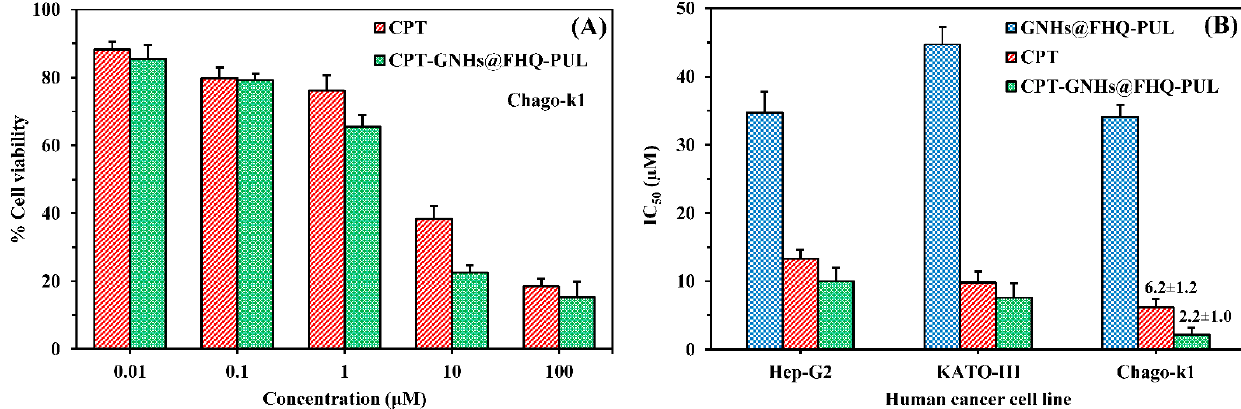
Figure 4. ( A ) % Cell viability in dose-dependent screening of CPT and CPT-GNHs@FHQ-PUL (0.01–100 μ M) against Chago-k1 cells. ( B ) Cytotoxicity (IC 50 ) of GNHs@FHQ-PUL, CPT, and CPT-GNHs@FHQ-PUL against three human cancer cells. Cytotoxicity was derived after 72 h exposure to NHs by MTT assay. Data are shown as mean ± 1SD, derived from three independent trials.